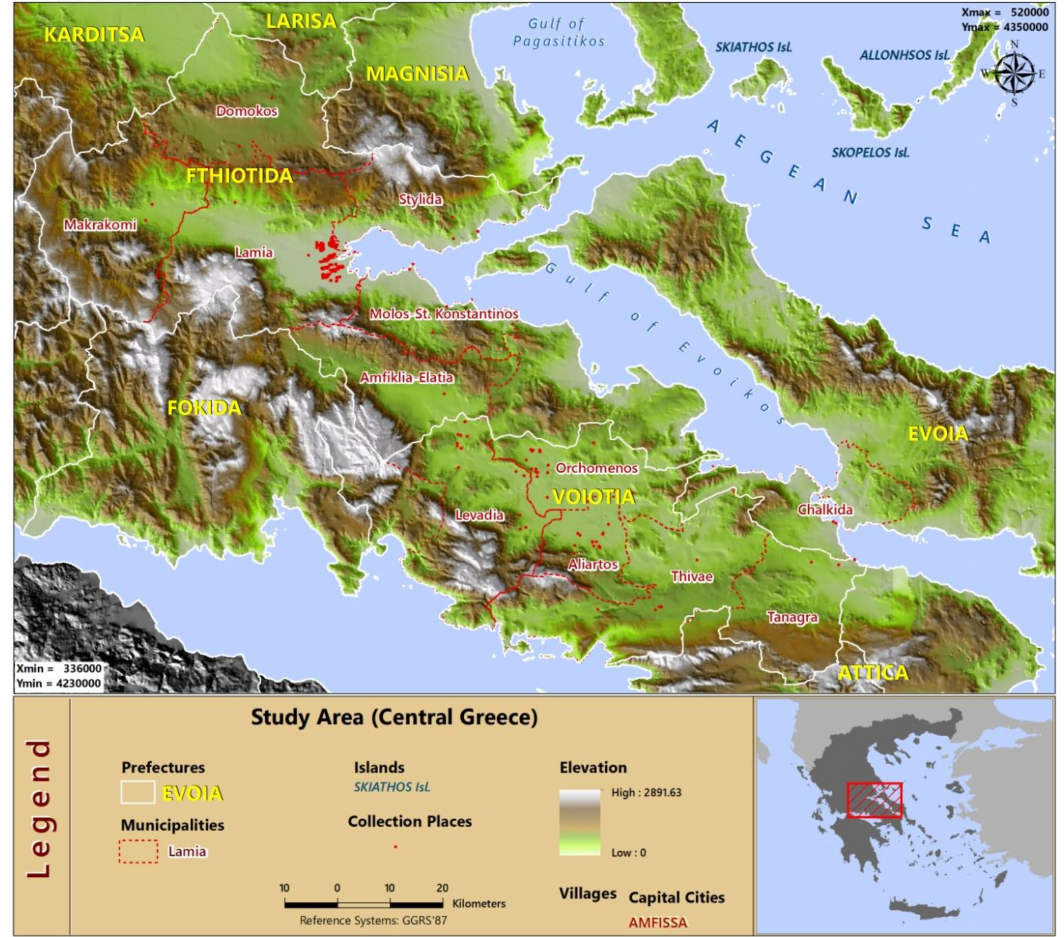
Figure 1. Map of study